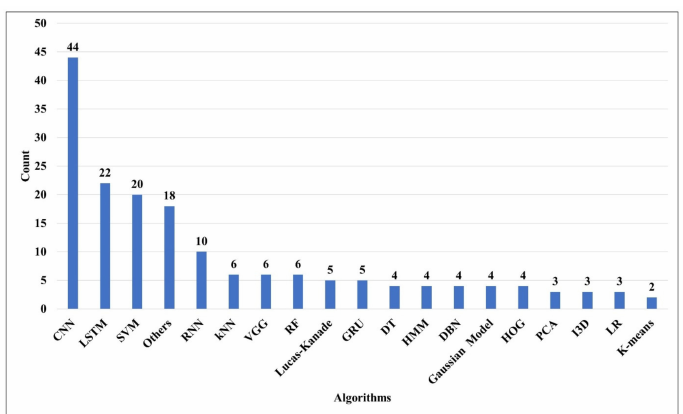
Figure 5. Frequency of techniques/algorithms used in the existing literature on